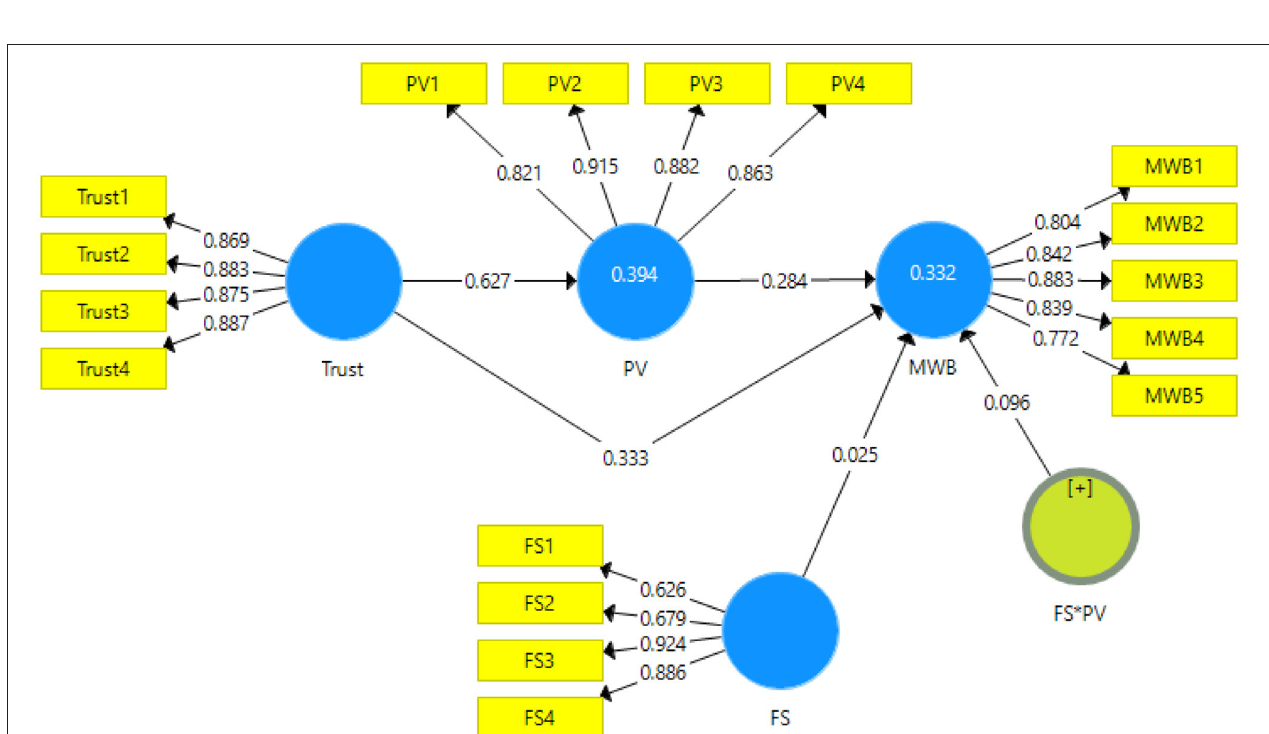
Frontiers in Public Health |